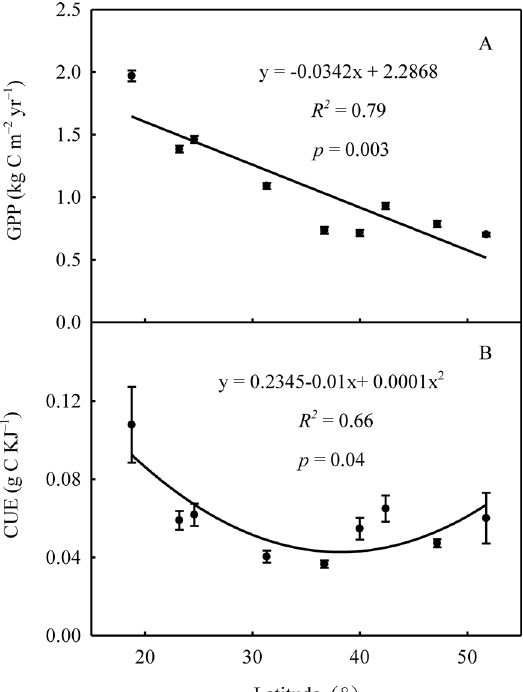
Fig 5. Latitudinal trends of gross primary productivity (GPP, kgC m – 2 yr – 1 ) and use efficiency of caloric value (CUE, gC KJ – 1 ) at the community level. Data are represented as mean ± S.E.